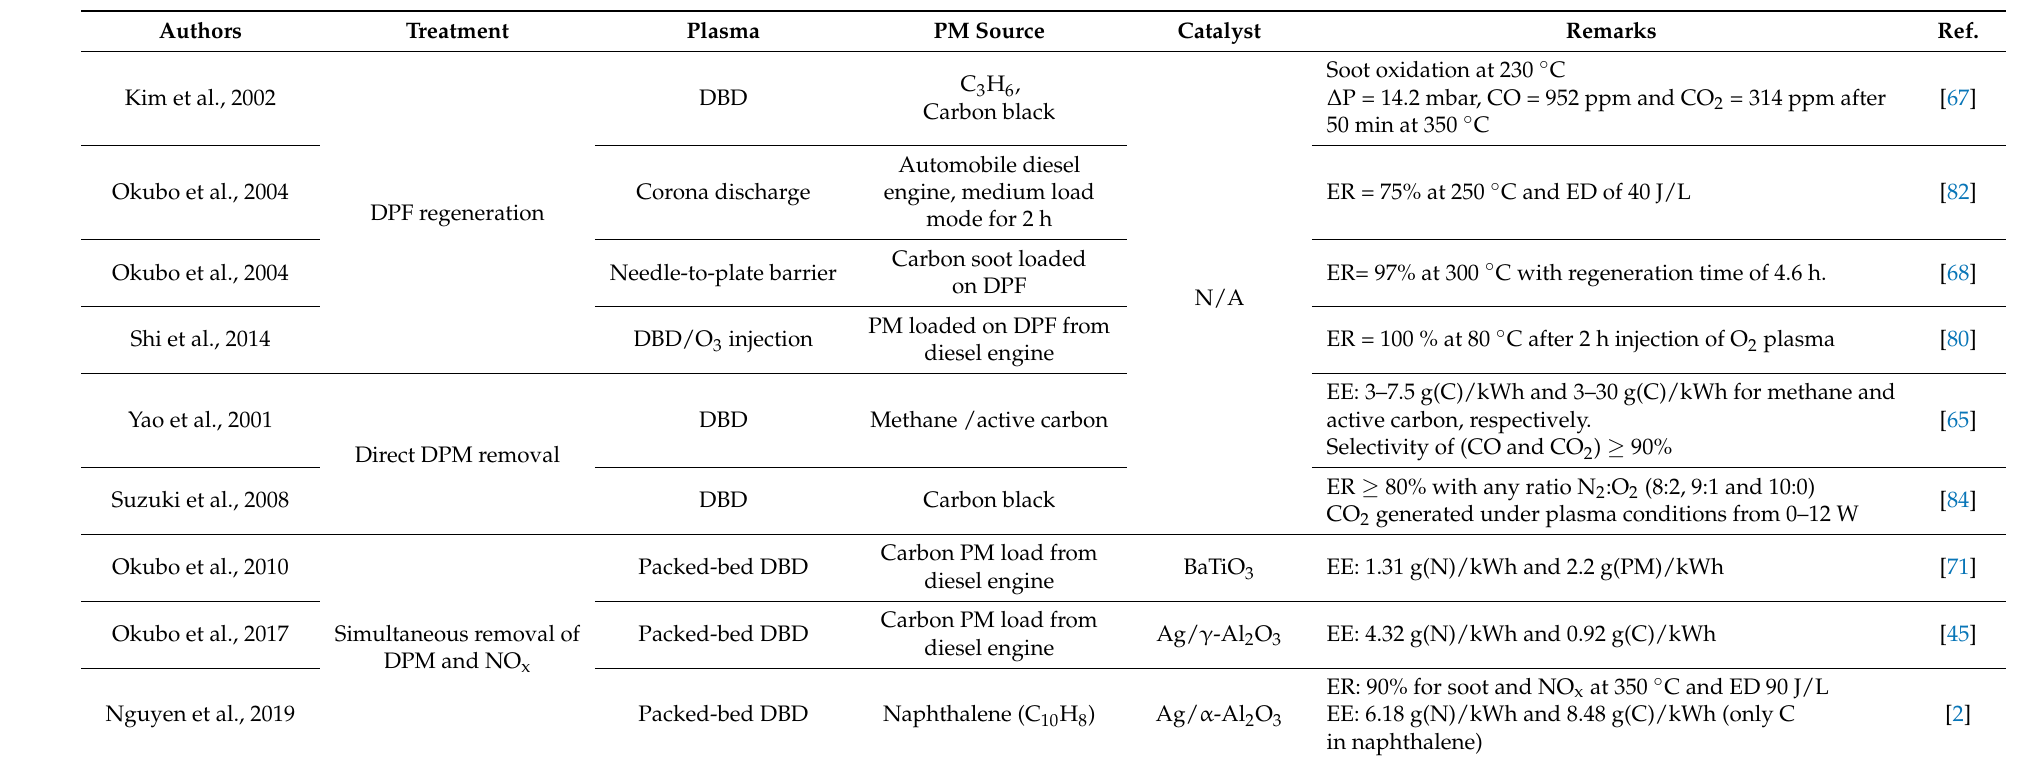
Table A1. A comprehensive review of published papers featuring non-thermal plasma for DPM treatment from simulated PM